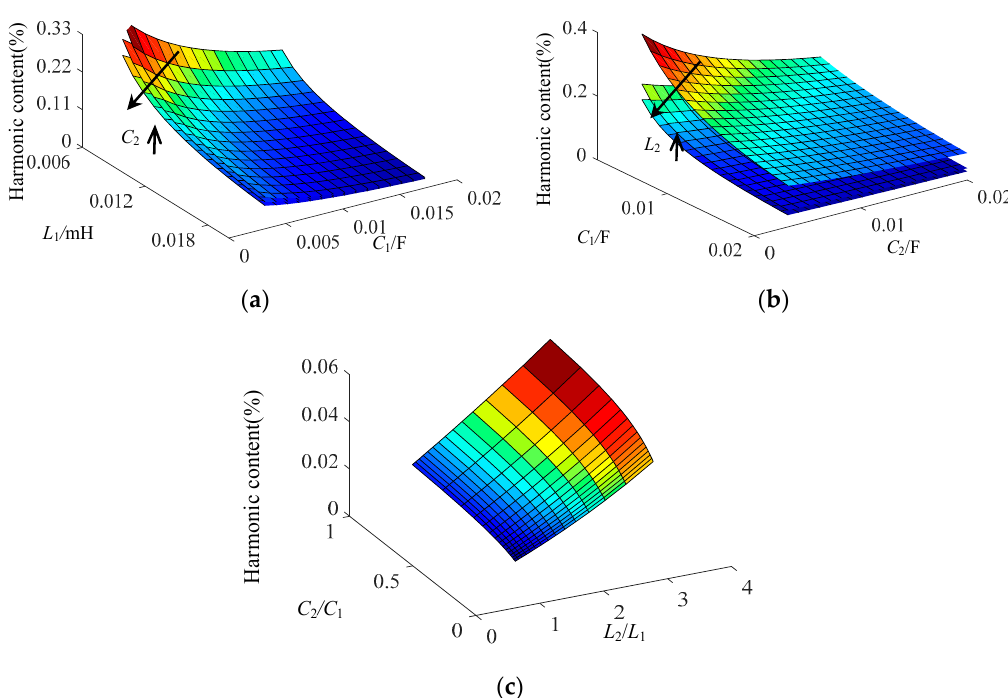
Figure 11. Relationship between the second harmonic content and parameters of the filter: ( a ) C 1 and L 1 ; ( b ) C 1 and C 2 , and ( c ) C 1/C 2 and L 2 / L 1 .